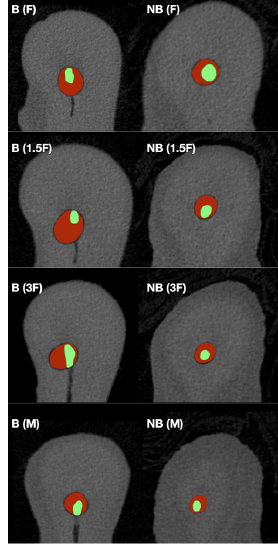
Figure 1. Micro-CT scan matching of pre- and post-shaping sections, according to previously selected cutting planes. Note the difference between pre-operative (green) and post-shaping with WaveOne Gold Primary (red) specimens at the furcation (F), 1.5 mm apically from the furcation (1.5F), 3 mm apically from the furcation (3F), and in correspondence with the point of maximum curvature (M). B = brushing group; NB = no-brushing group.